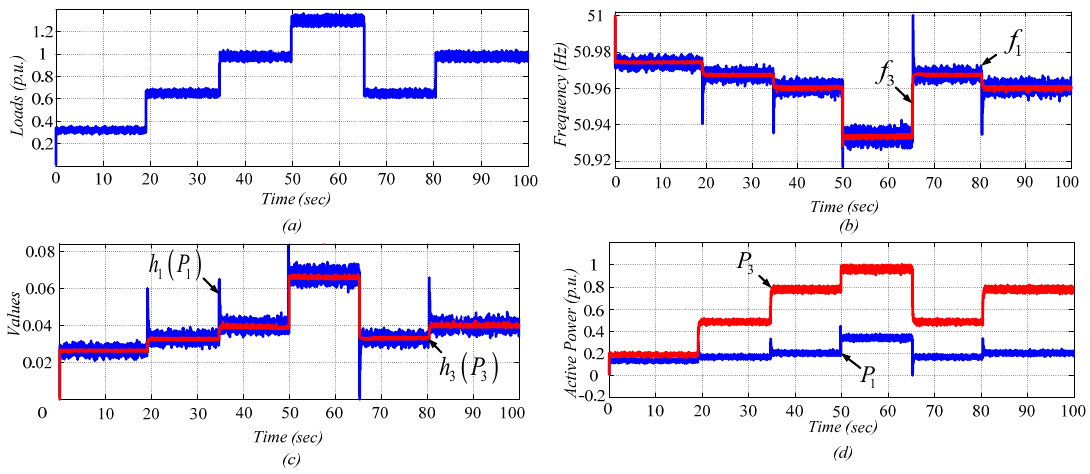
Figure 15. Waveforms of ( a ) the load; ( b ) frequency; ( c ) h i ( P i ) values; and ( d ) DGs’ active power outputs.